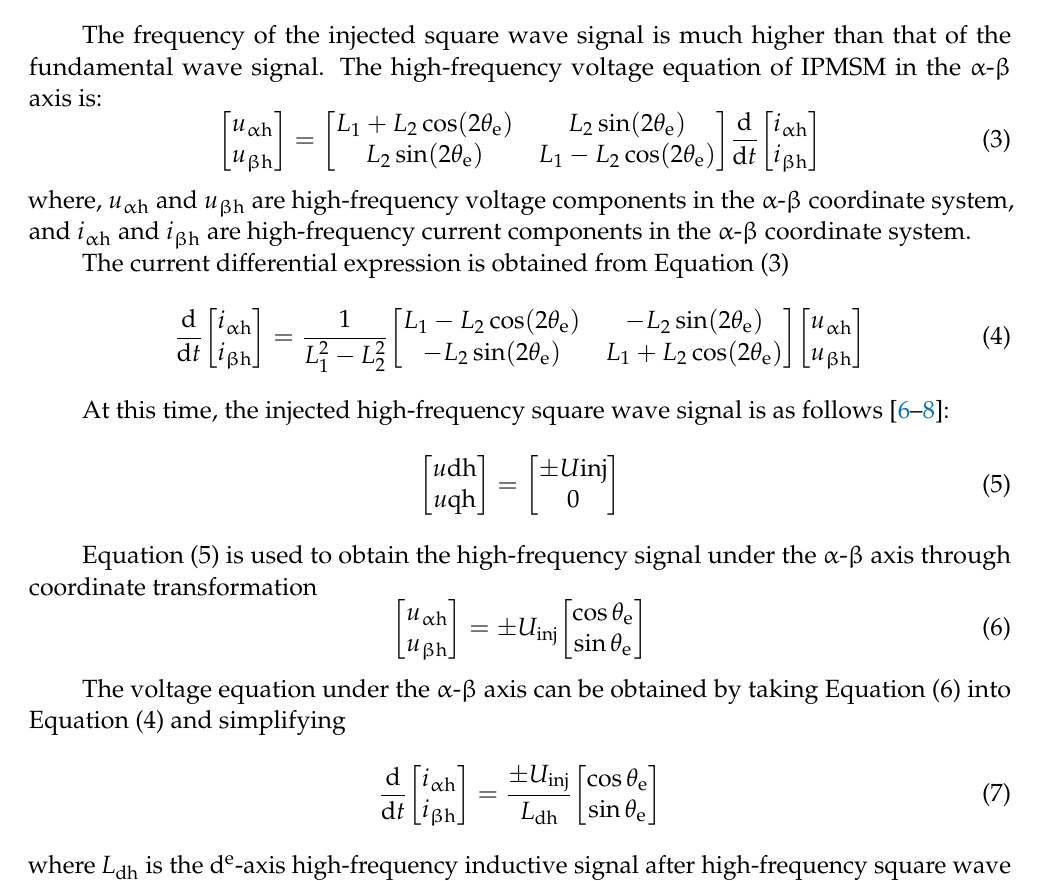
Figure 3. Traditional method of injecting signals and sampling points.